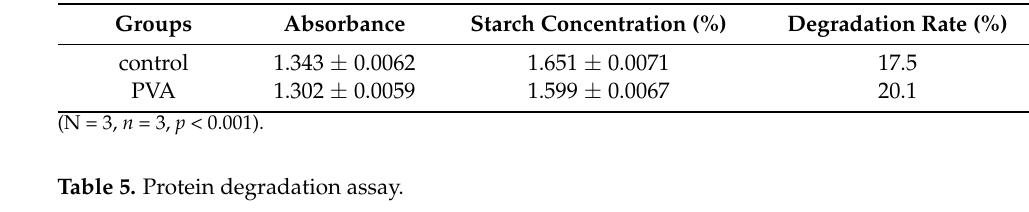
Table 4. Protein degradation assay.